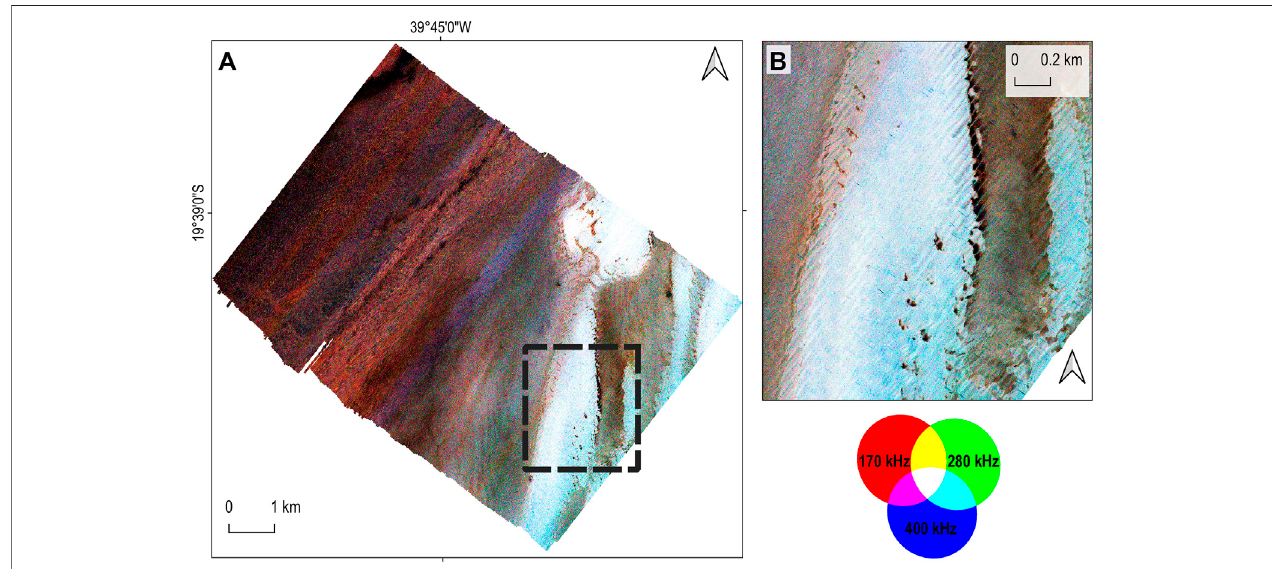
FIGURE 9| Compositeimage (RGB) representing the three frequencies (A) For the whole study area; (B) Frame over the sandy feature. Pixels are stretched to the minimum and maximum values for each band. No changes of color rendering parameters were applied (hue, saturation and contrast).